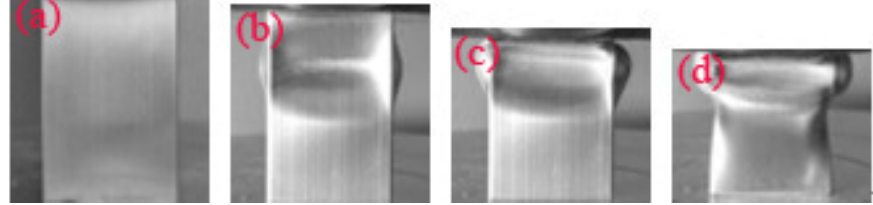
Figure 8. Typical deformation of an empty tube at a strain of ( a ) 2.6%; ( b ) 10%; ( c ) 20%; ( d ) 30%.